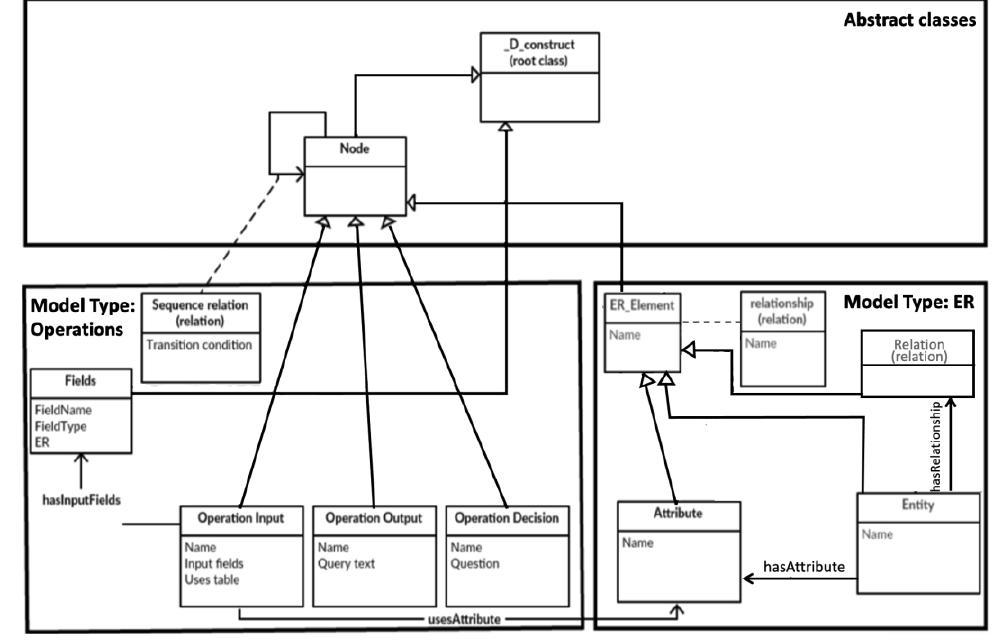
Figure 2. The metamodel